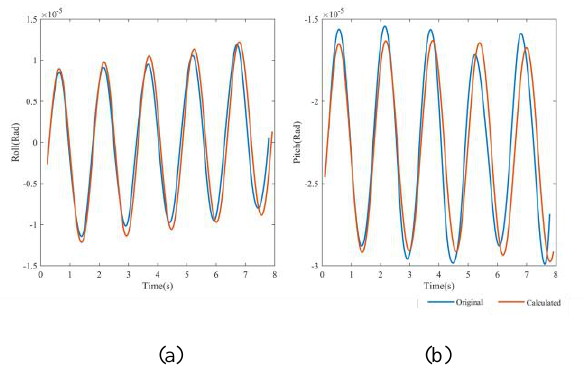
Figure 5 . Comparison of attitude results of CCD2